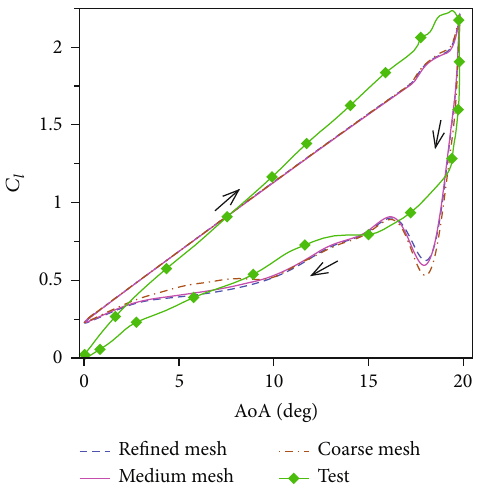
Figure 5: Comparison of lift coe ffi cients between the numerical and test data.